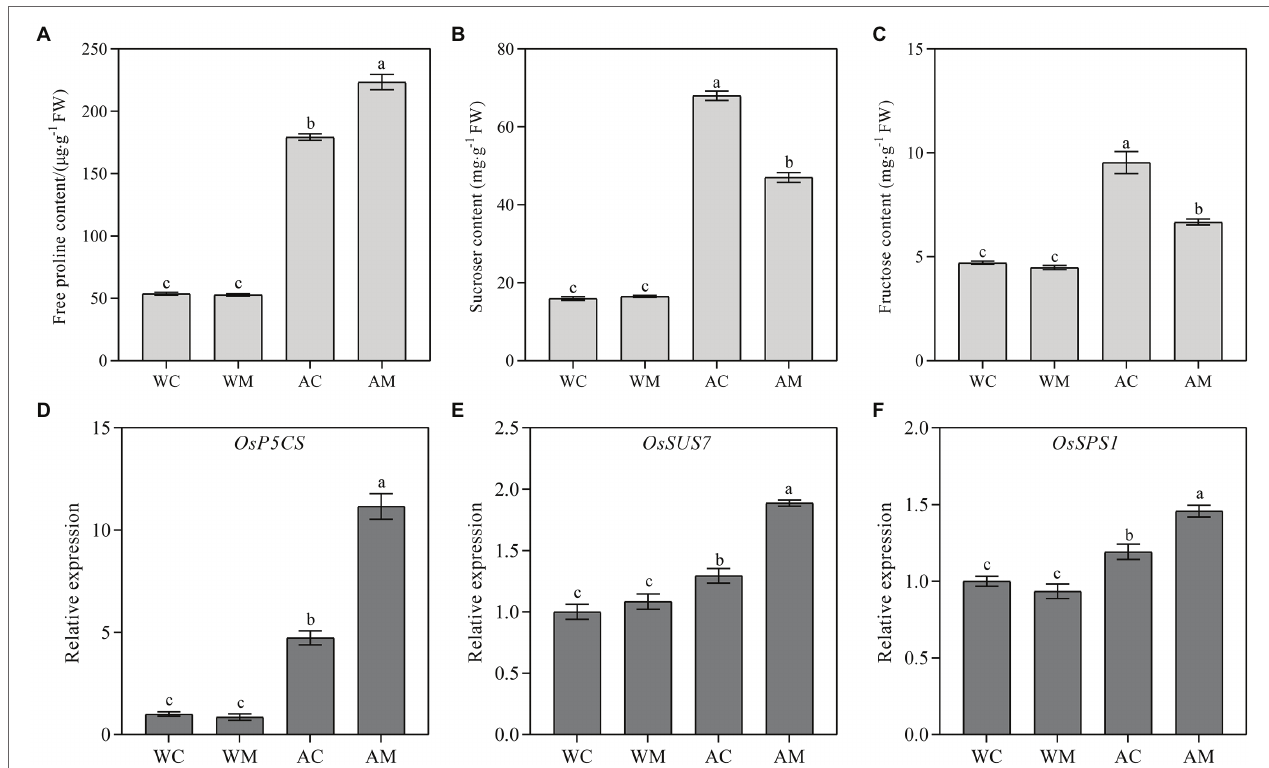
FIGURE 7 | Effects of exogenous MT on proline, sucrose, fructose content, and their related gene expression. (A) Proline content; (B) Sucrose content; (C) Fructose content; and (D–F) OsP5CS , OsSUS7 , and OsSPS1 relative expression level. Data represent means ± SEs of three replicate samples. Different letters denote significant differences ( n = 3, and p < 0.05). WC, control; WM, control pretreated with MT; AC, alkaline stress; and AM, alkaline-stressed plants pretreated with MT.